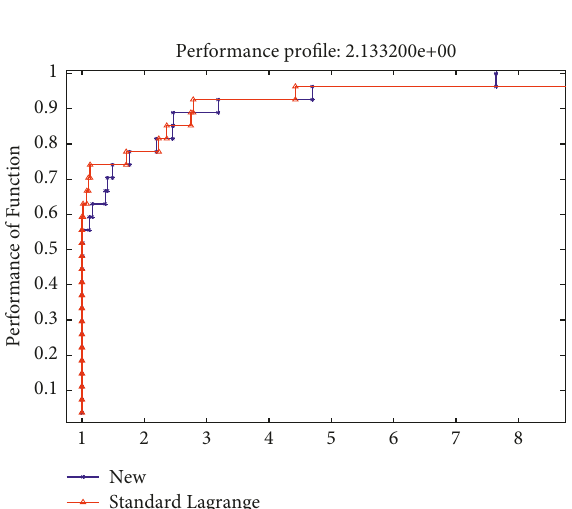
Figure 2: The performance of the given methods relative to the number of function